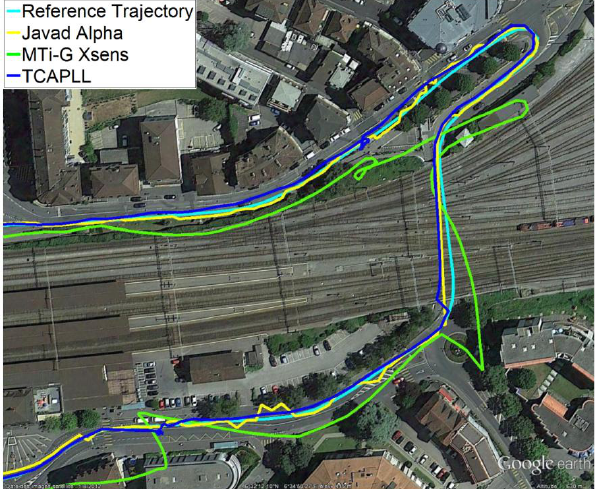
Figure 27. Position solution in Renens center and during a 10 s tunnel under the railway